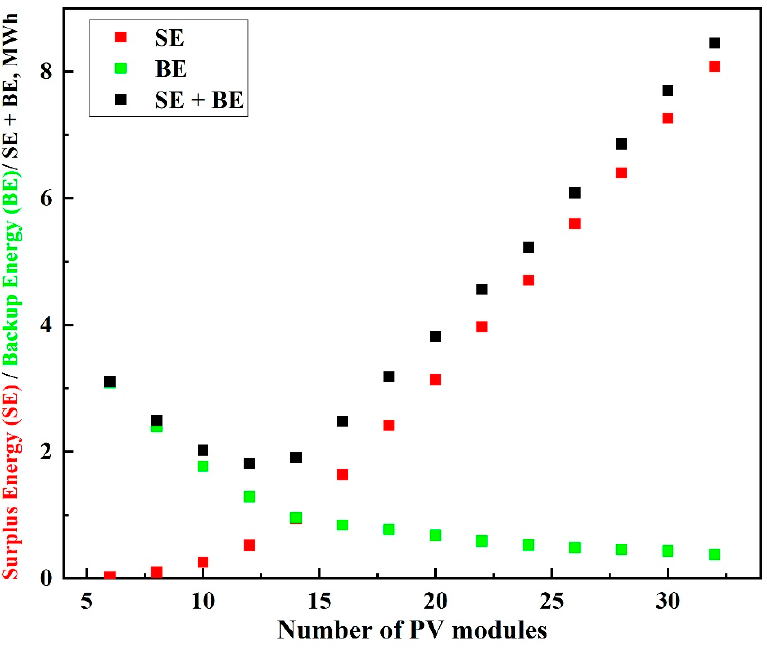
Figure 8. Marker chart depicting 14 simulation instances with constant Bnec and varying PV module number. The descending change of the backup energy and the ascending change of discarded surplus energy indicate the optimal PV panel quantity for which the solar generation is maximized.